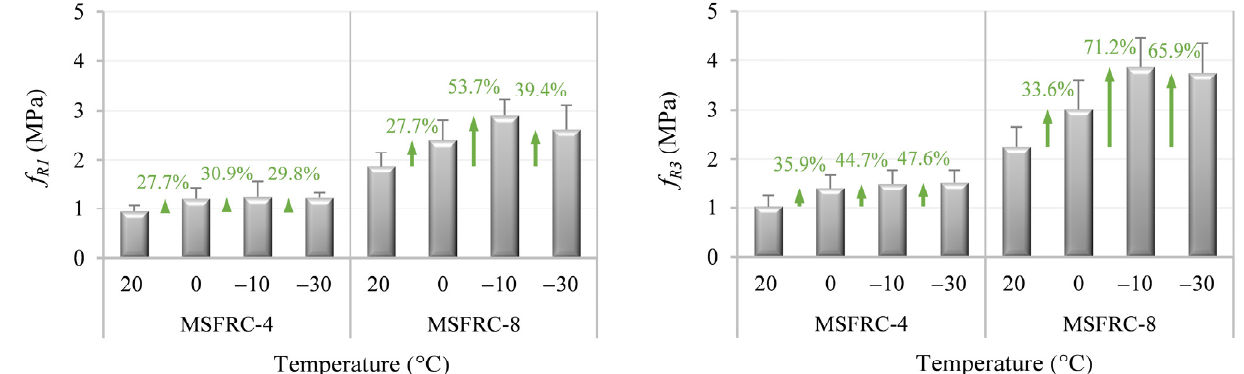
Figure 5. Mean values of f R1 and f R3 with corresponding standard deviations of the studied MSFRCs at different temperatures.